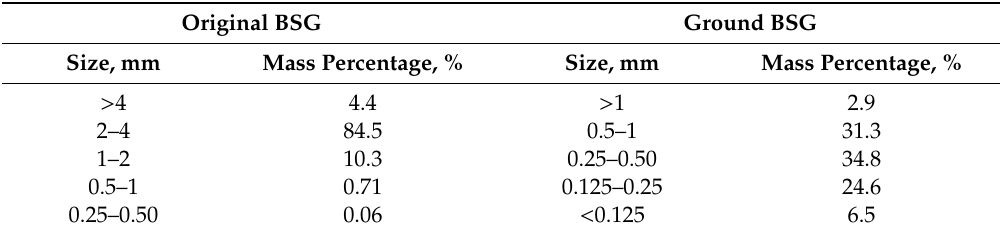
Table 1. Particle size distribution of the original brewer’s spent grain (BSG) and ground